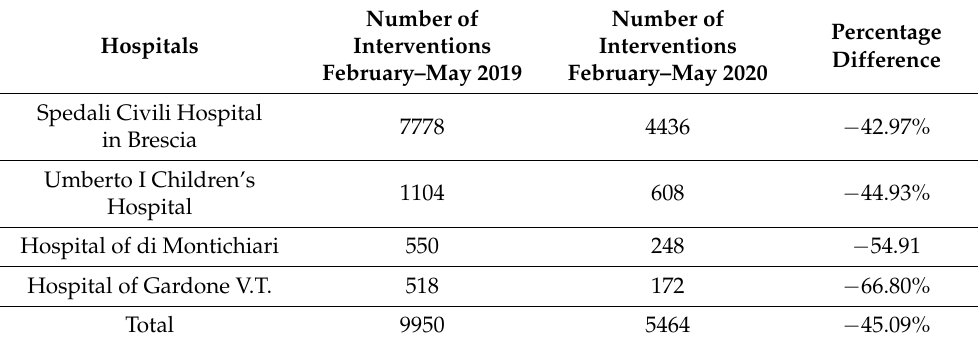
Table 8. In-patient surgeries performed.